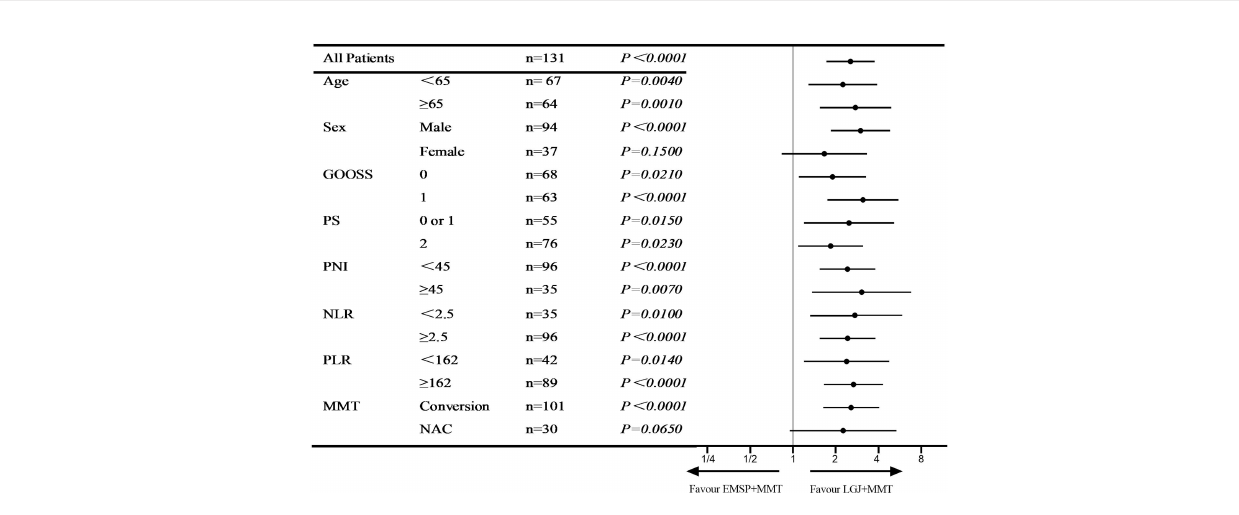
FIGURE 2 | Hazard ratio for overall survival. Forest plot evaluating the impact of treatment models on OS after LGJ+MMT vs EMSP+MMT.